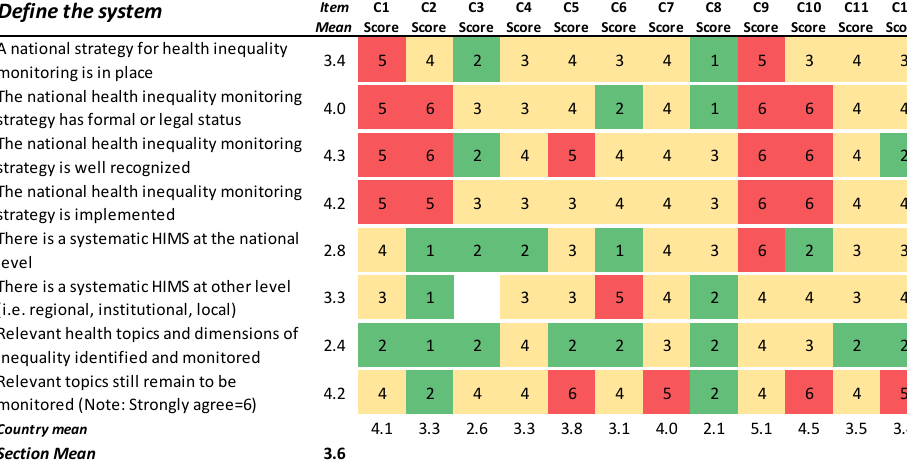
Figure 1. Results for the section ‘Define the system’. Green cells (scores 1–2) indicate agreement with the statement. Yellow cells (scores 3–4) indicate partial agreement/disagreement, and red cells (scores 5–6) indicate the most challenging preconditions for the ideal HIMS.